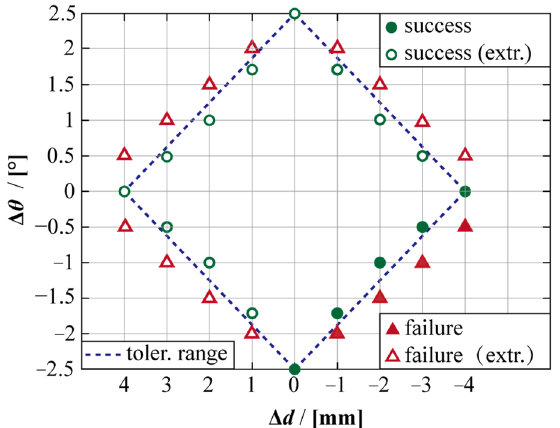
Figure 20. Kinematic results of tolerance range of the docking mechanism. Δ d represents the two linear deviations, Δ θ represents the three angular deviations, the dashed line represents the estimate tolerance range, the circles represent successful docking, and the triangles represent failed docking. Empty symbols are considered according to the central symmetry of structure to be extrapolated results.